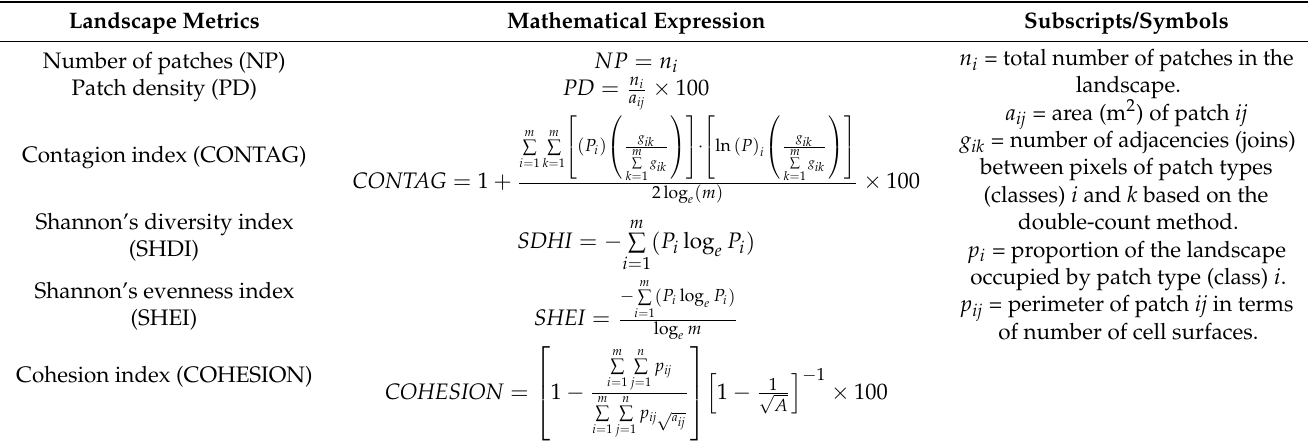
Table 2. Landscape pattern index.